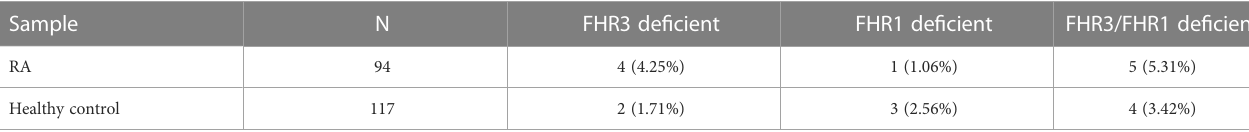
TABLE 4 Overview of FHR1- and FHR3-de fi ciency in the RA patients and healthy controls.